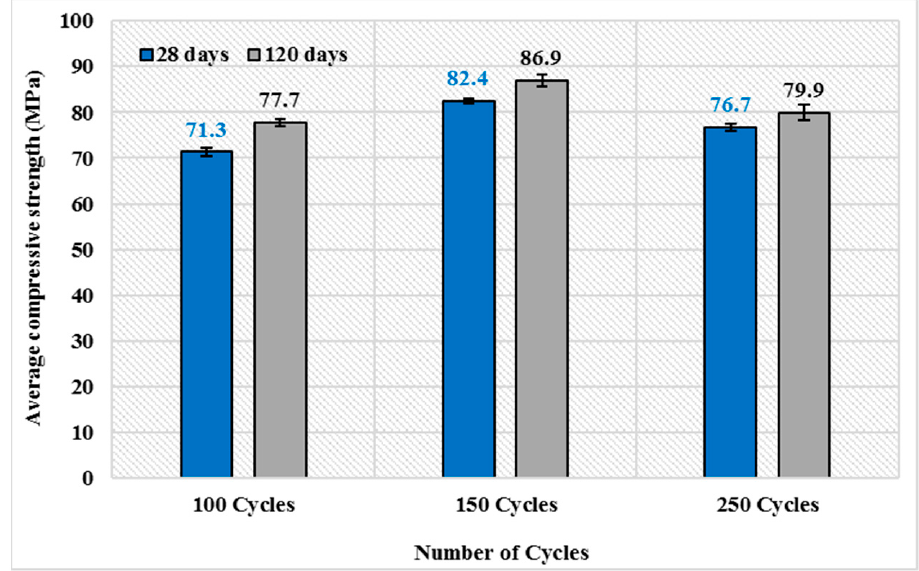
Figure 5. Effect of the number of cycles used in water magnetization.